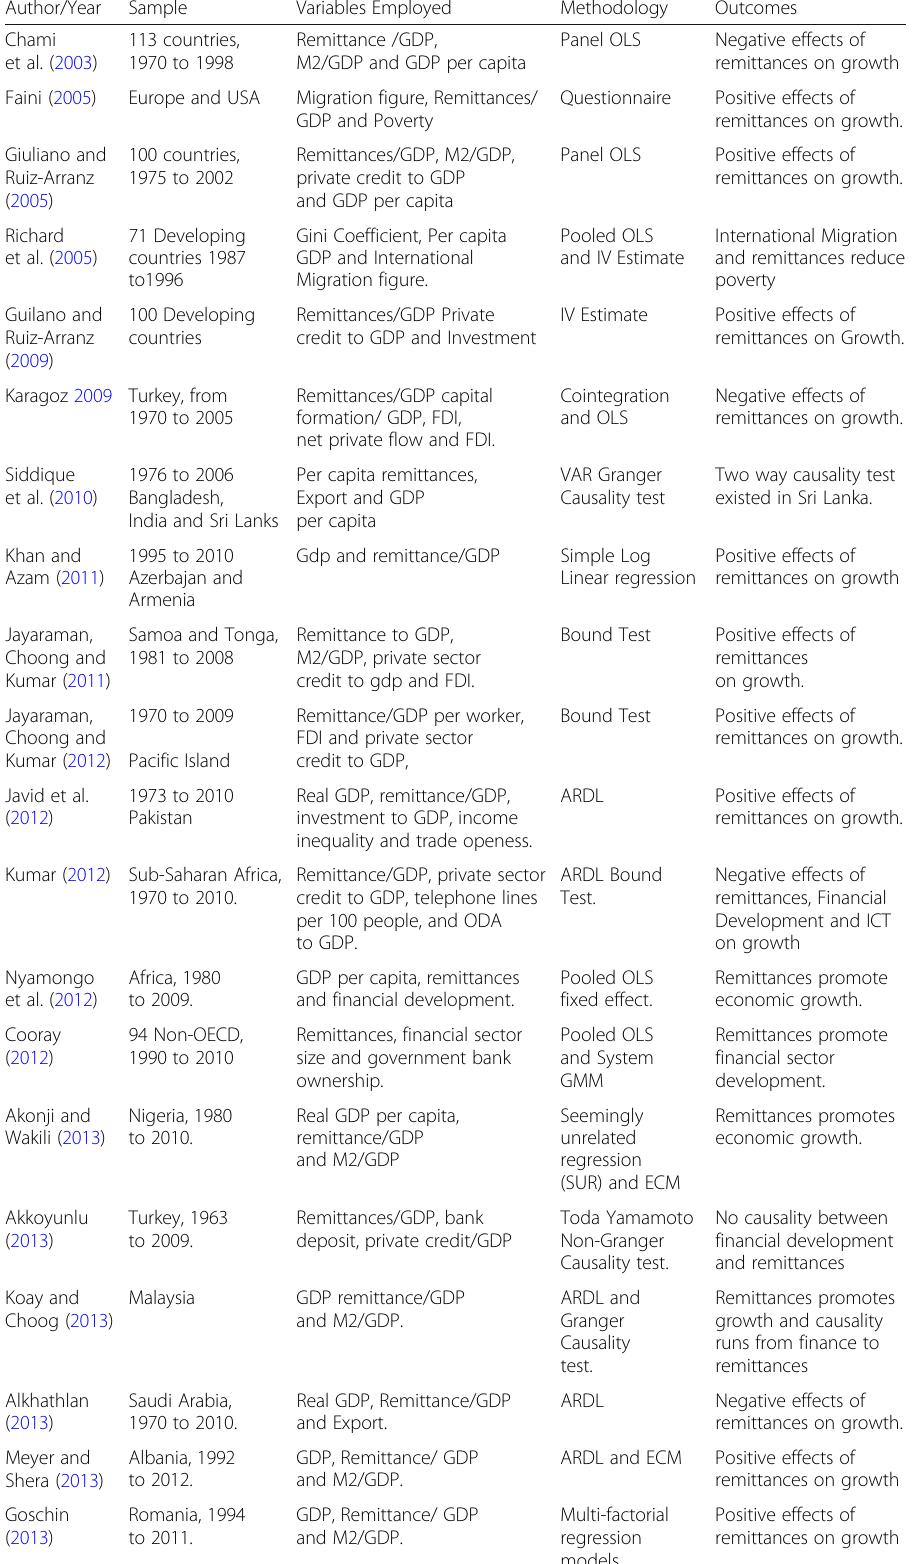
Table 2 Tabular Summary of the Literature